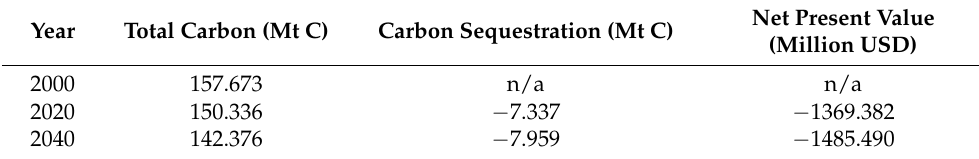
Table 5. Total carbon stored, carbon sequestration, and net present value derived from InVEST